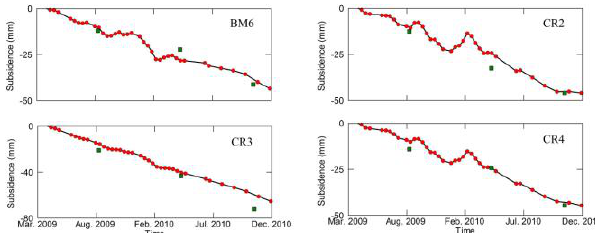
Figure 6. Time series of subsidence values (by red dots) derived from the MTI solution at BM6, CR2, CR3 and CR4. The subsidence values obtained by leveling are indicated by green squares.